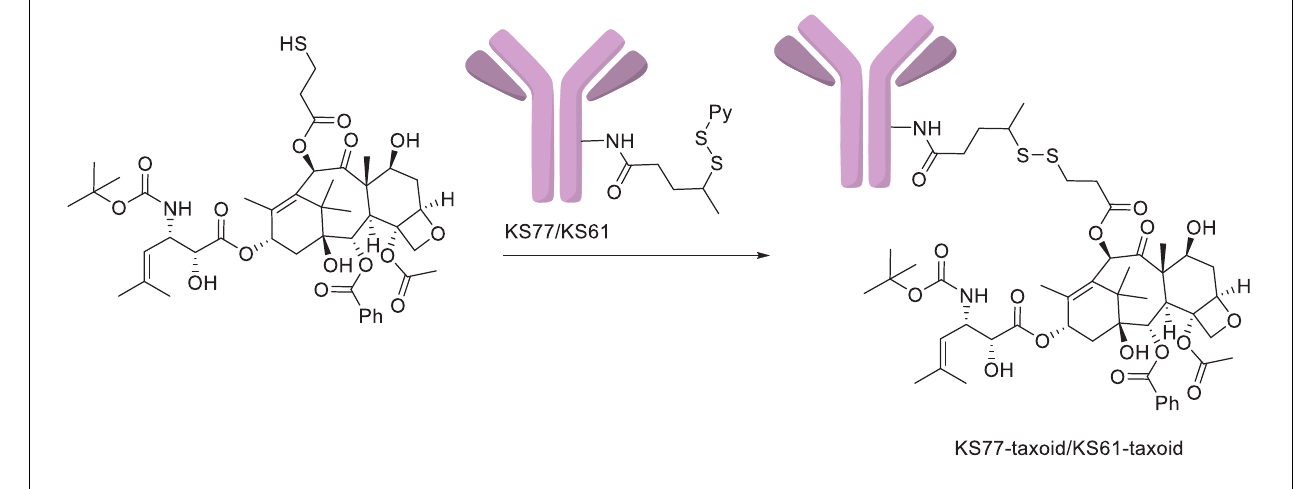
FIGURE 7 | The KS77/KS61–PTX conjugates (Ojima et al., 2002).